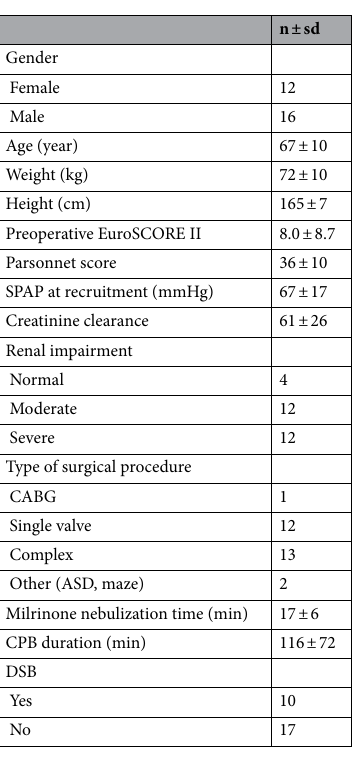
Table 1. Patient demographic and perioperative data. ASD atrial septal defect, CABG coronary artery bypass graft, CPB cardiopulmonary bypass, DSB difficult separation from CPB, SPAP systolic pulmonary artery pressure, sd standard deviation.